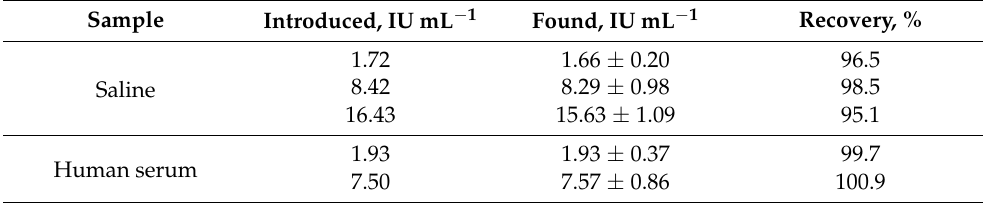
Table 2. Determination of heparin in model samples using the AuNPs/PMS1-modified GC electrode by standard addition method (n ≤